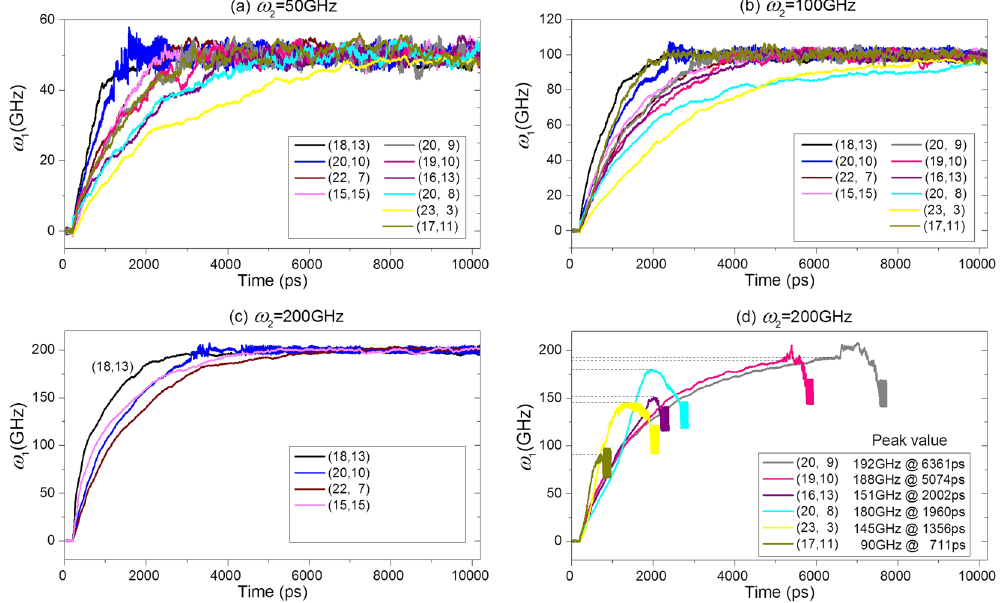
Figure 2. The history curves of ω 1 , the output rotational frequency of Rotor1 when driven by Rotor2 with different input rotational frequency of ω 2 in the A-type